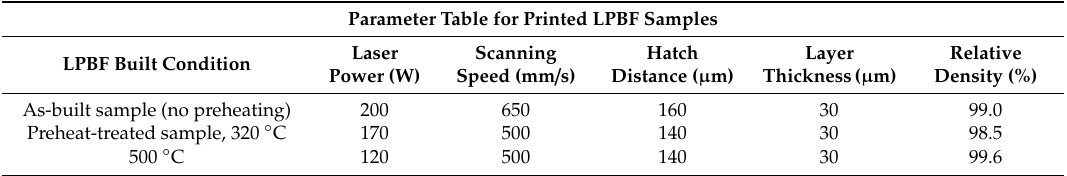
Table 2. Laser Powder Bed Fusion (LPBF) process parameters of densest test